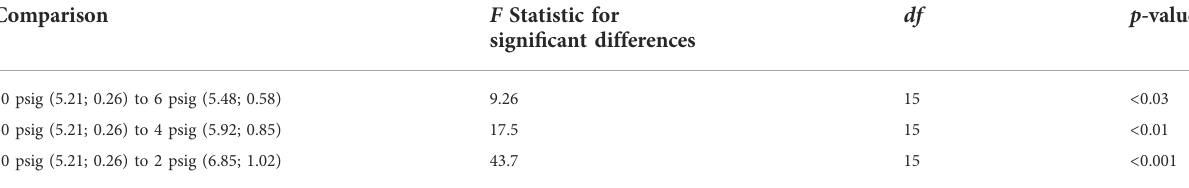
TABLE 3 Contrast statistics from repeated measures ANOVA analysis of maximum regulator outlet